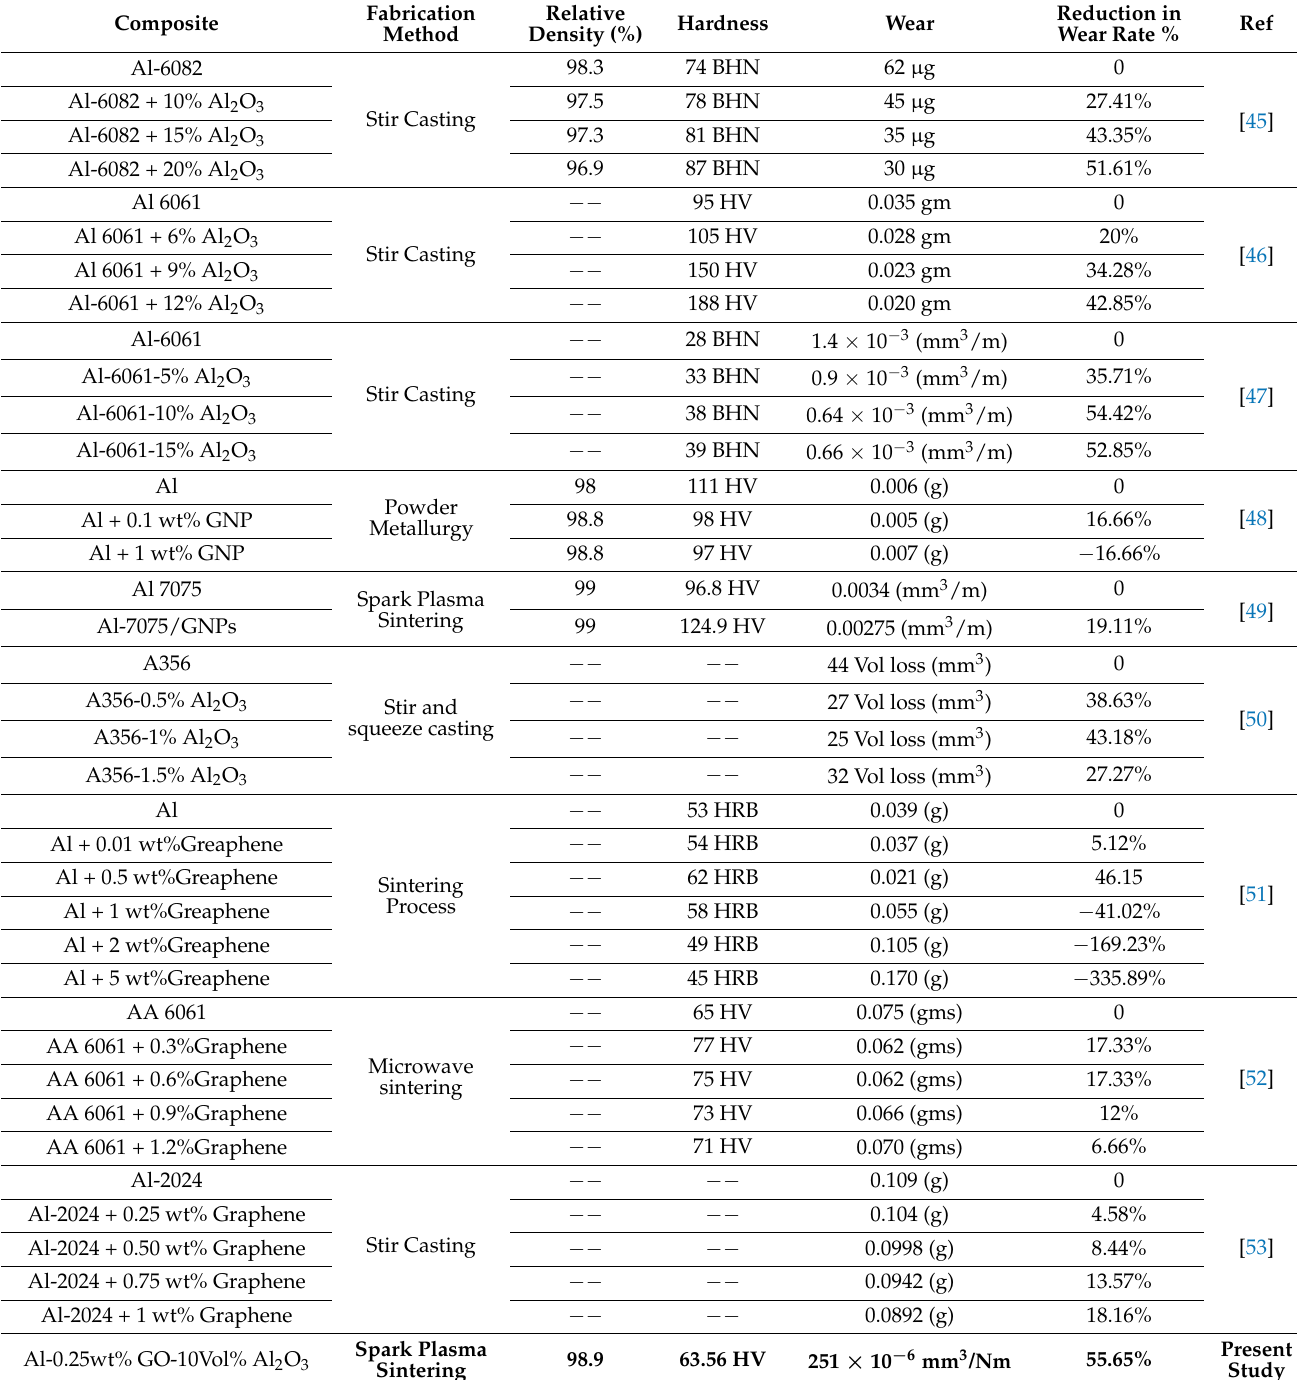
Table 4. Comparative analysis of the results reports in the literature related to Al-based